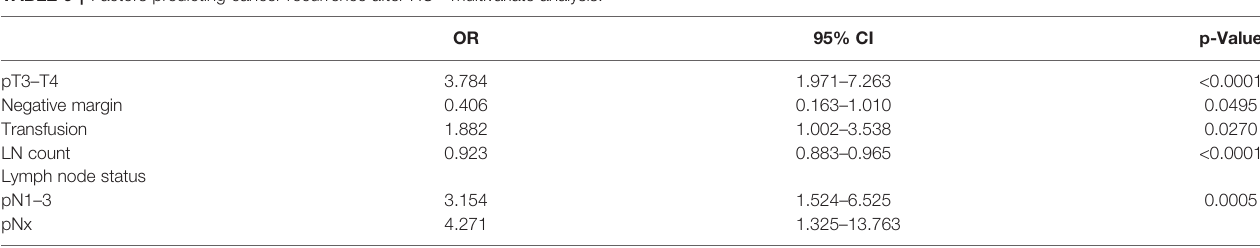
OR, odds ratio; NAC, neoadjuvant chemotherapy; BMI, body mass index; UCS, uretero-ureterocutaneostomy; TU-UCS, transuretero-ureterocutaneostomy; MIBC, muscle-invasive bladder cancer; UD, urinary diversion. TABLE 6 | Factors predicting cancer recurrence after RC — multivariate analysis.